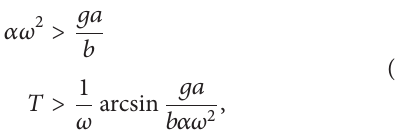
Figure 5: Amplitude of oscillation versus frequency of oscillation at various ] = 𝑎/𝑏